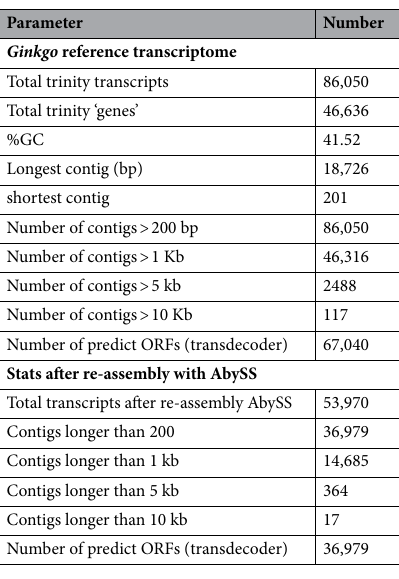
Table 1. Statistics for Ginkgo reference transcriptome. The initial assembly was improved with a re-assembly method using